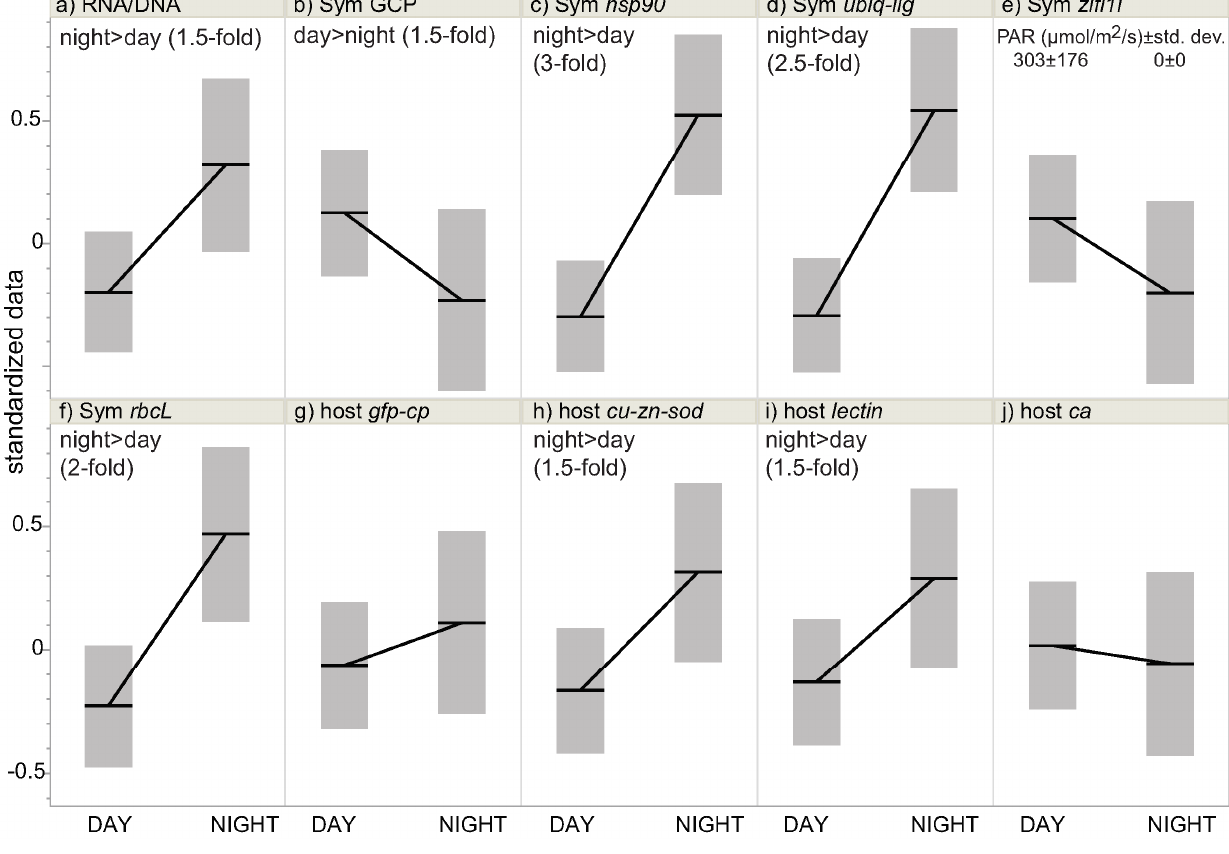
Figure 3. Light effects on 10 coral response variables. In contrast to Figure 2, data were pooled across the two light sampling windows (before 10:00 and 10:00–14:00; PAR = 455 ± 151 and 267 ± 161 µmol/m 2 /s, respectively) in this figure, with the differences vs. dark-sampled colonies tested with Wilcoxon tests (on ranks) for each of the 10 response variables ( a – j ). Grey bands depict 95% confidence, and the trend and fold difference included in the upper left-hand corner of the plot represent statistical significance according to the Wilcoxon test ( p < 0.02). Mean day and night PAR levels at the position of the sampled coral colonies are included at the top of panel e.